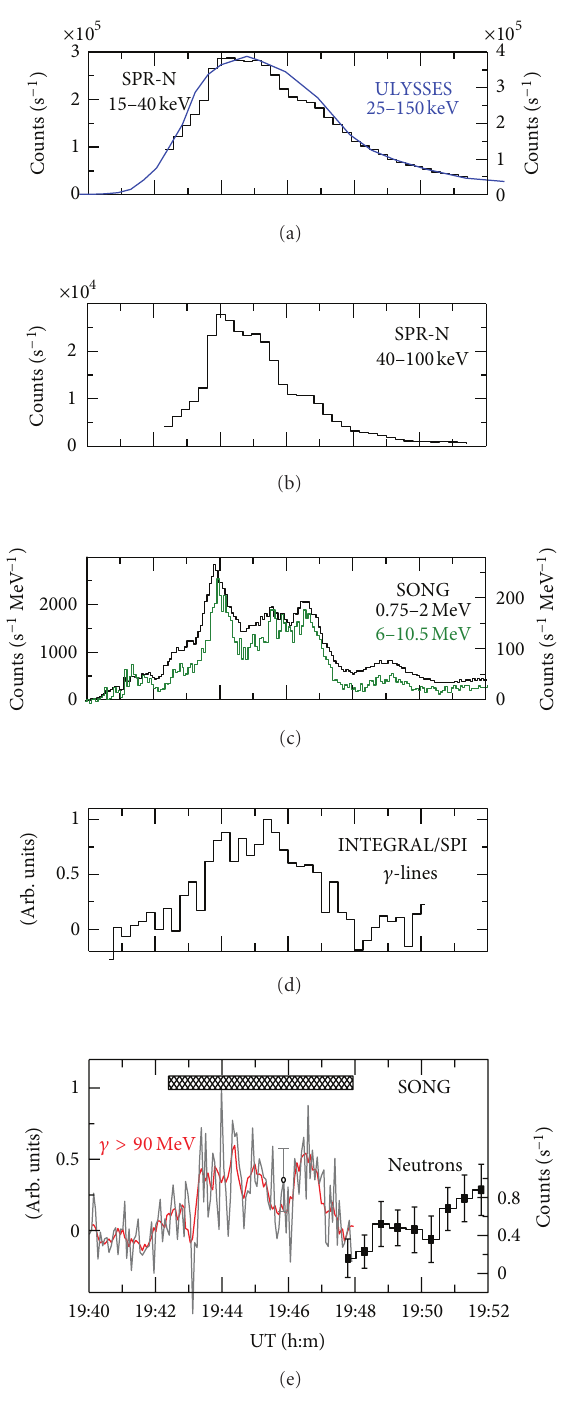
Figure 7: Time profiles of selected emissions from the November 4, 2003, flare: (a) hard X-ray measured by Ulysses (blue curve, right 𝑦 - axis) and CORONAS-F/SPR-N (black curve, left 𝑦 -axis); (b) hard X-rays (40–100keV) from CORONAS-F/SPR-N; (c) gamma-rays 0.75–2 MeV (black, left 𝑦 -axis) and 6–10.5 MeV (green, right 𝑦 -axis) from CORONAS-F/SONG; (d) summarized normalized intensity of the 4.4 MeV + 6.1MeV gamma-lines from INTEGRAL/SPI [53]; (e) gamma-rays > 90MeV (gray, left 𝑦 -axis, data are normalized) and neutrons (black, right 𝑦 -axis) from CORONAS-F/SONG. Red curve in the bottom panel presents smoothed data on gamma-rays.